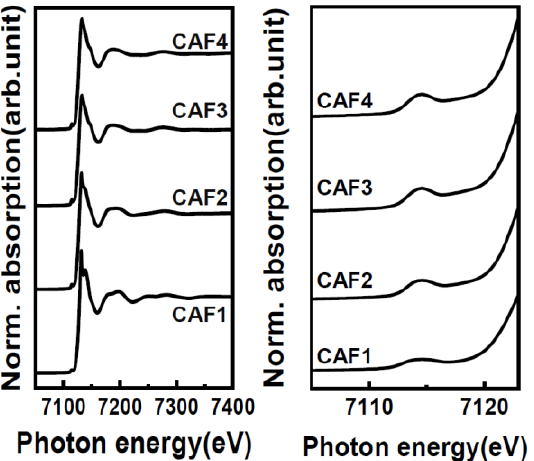
Figure 5. Fe K-edge XANES spectra for Ca–Al–Fe LDHs with various Ca/Al/Fe ratios (right panel shows magnified spectra around pre-edge region).